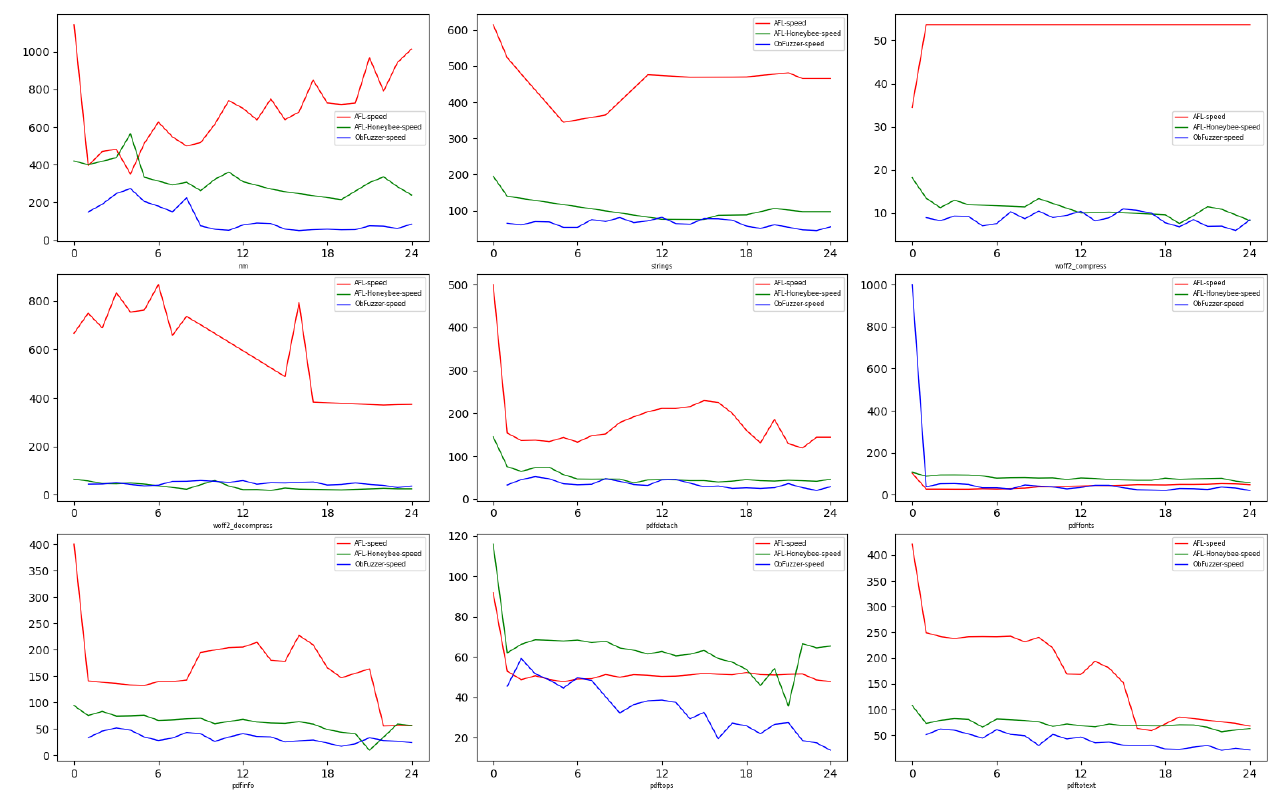
Figure 10. Execution Speed of AFL, AFL-Honeybee and ObFuzzer Fuzzing Phase. In Figure 10, the x -axis represents test time (hours) and the y -axis represents the number of executions per second. The red line represents the execution efficiency of AFL, the green line represents the execution efficiency of AFL-Honeybee and the blue line represents the execution efficiency of ObFuzzer fuzzing phase. Experimentation shows